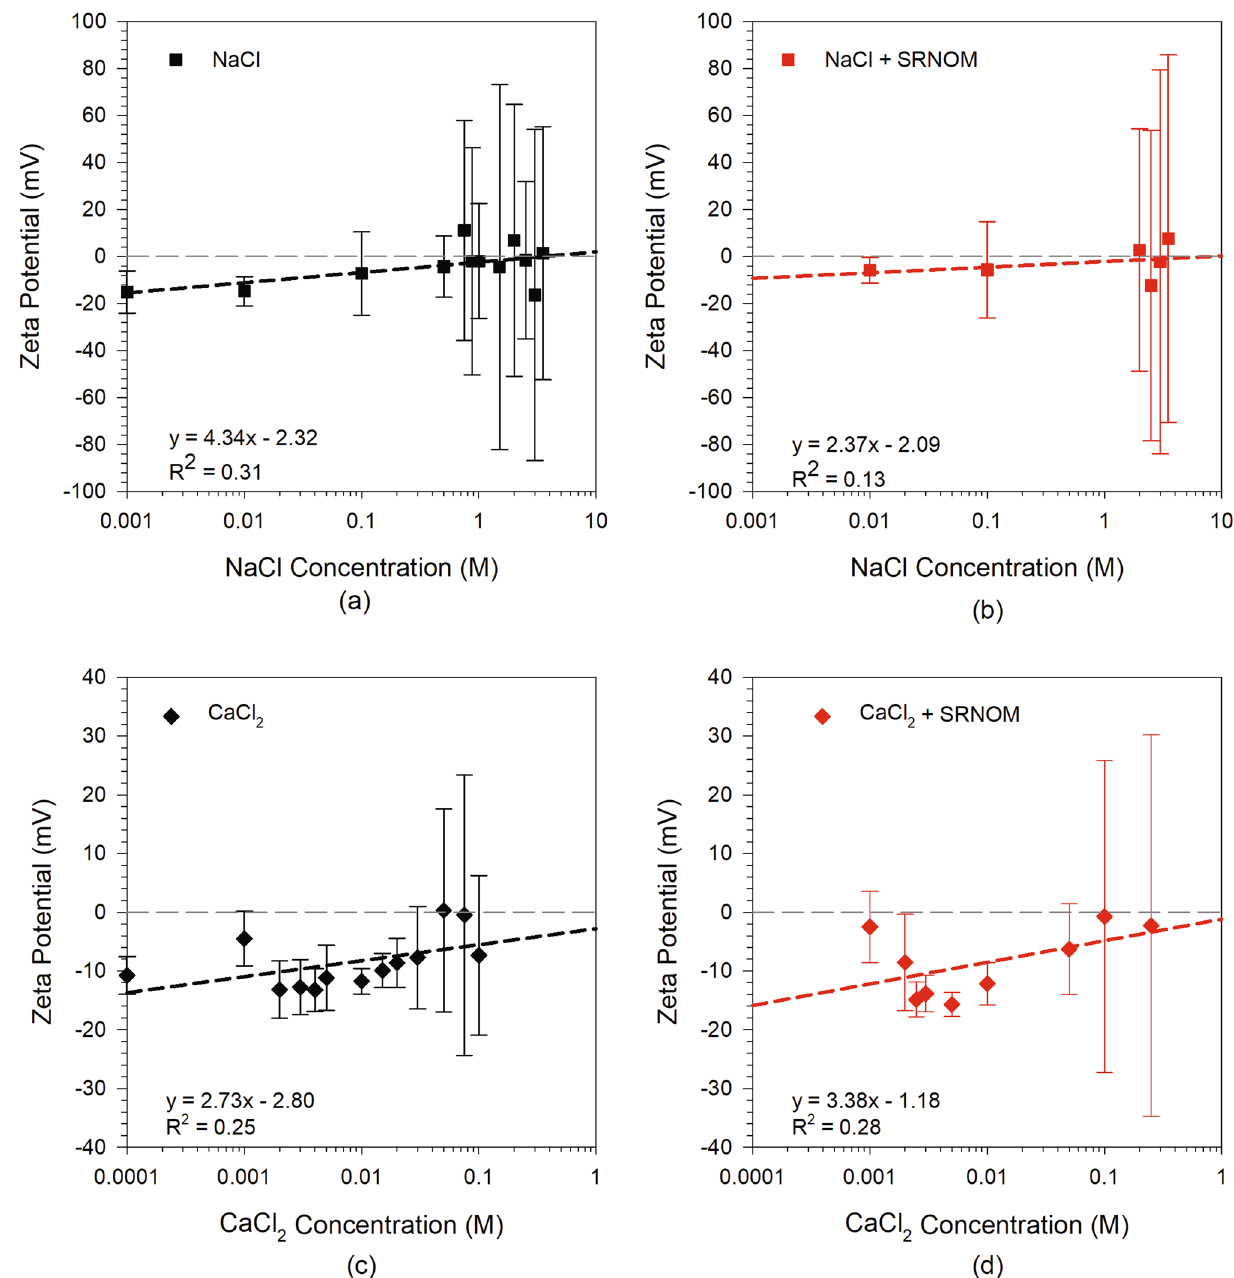
electrolyte NaCl in the presence of SRNOM at 10 mg/L, c Divalent electrolyte CaCl , and d Divalent electrolyte CaCl in the presence 2 2 of SRNOM at 10